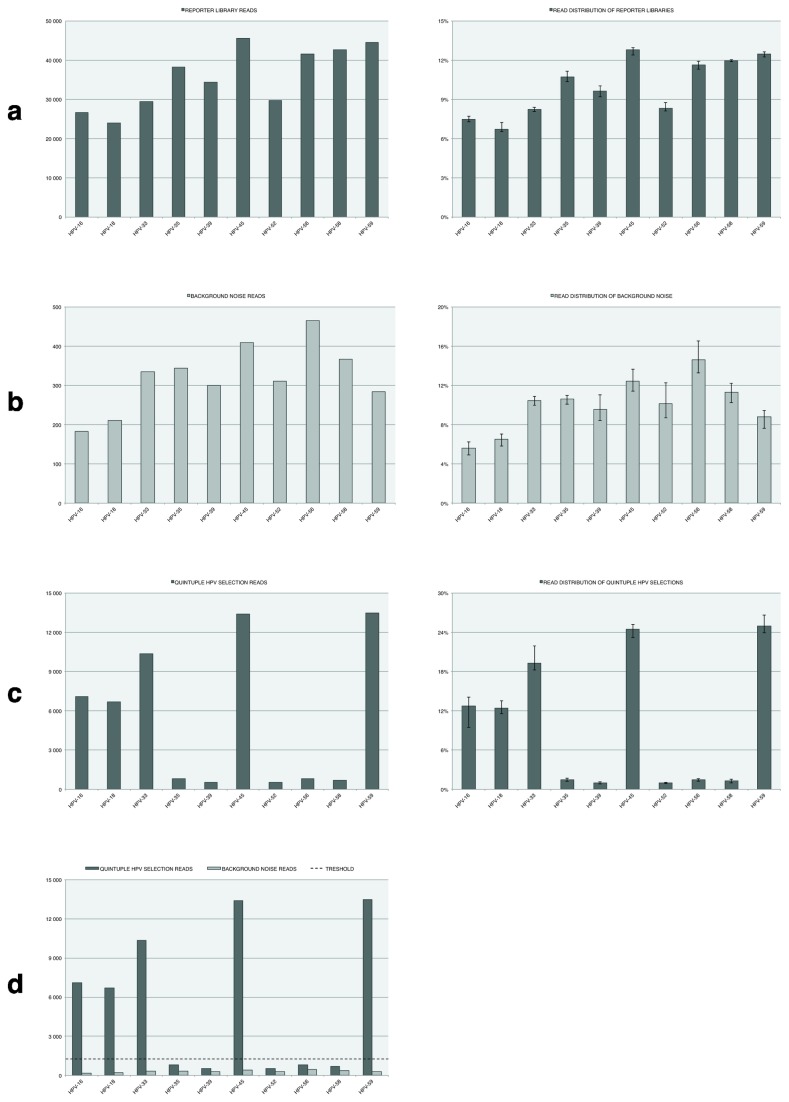
Reporter library construction and Sequencing Bead Array (SBA) assay performance.In (a-c), the left-hand side bar-histograms detail y-axis average read counts, while the right-hand side detail y-axis read distribution percentages amongst the ten reporters. Error-bars are also included in the right-hand side graphs to illustrate the read distribution variability amongst the replicates. The upper error-bar value is the highest observed frequency, while the lower error-bar value is the lowest observed frequency. (a) Results from six individually constructed reporter libraries sequenced side-by-side without any prior selections (metadata Table S2). (b) Results from six parallel negative (water) selections showing the background noise effects (metadata Table S3). (c) Results from six quintuple HPV selections of equimolar amounts of PCR-products derived from Human Papillomavirus (HPV) plasmids HPV-16, HPV-18, HPV-33, HPV-45, and HPV-59 (metadata Table S4). (d) Read count bar-histograms (b and c) superimposed with the experimentally established threshold value (dashed line) of ~1261.5 reads, which clearly distinguishes a positive call from the background noise.